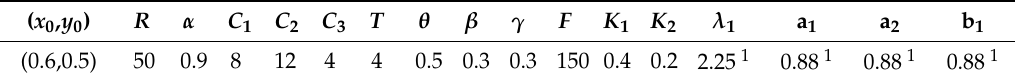
Table 5. The parameter